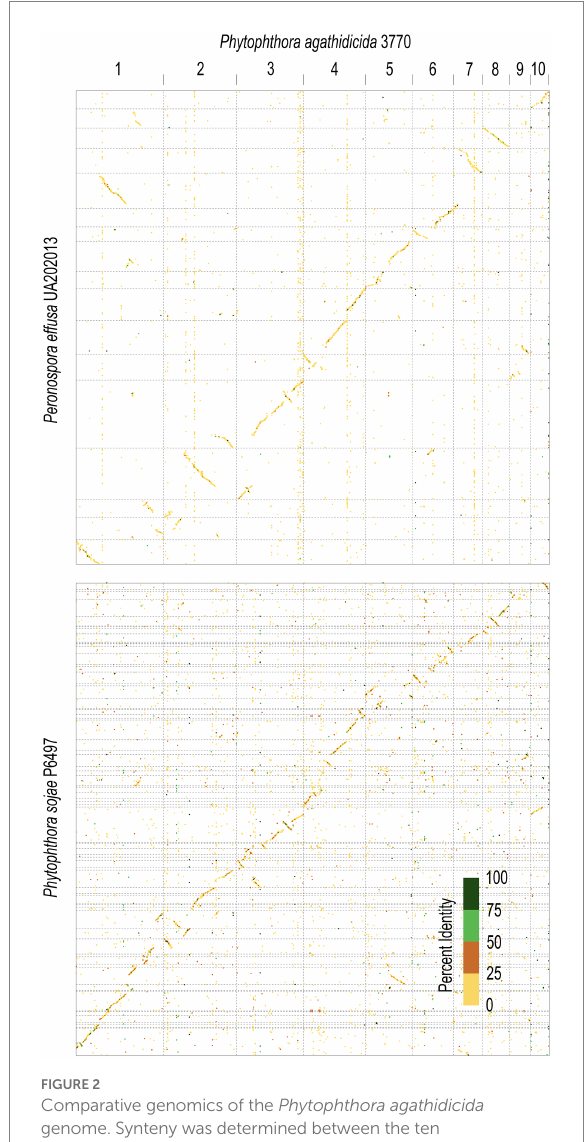
FIGURE 2 Comparative genomics of the Phytophthora agathidicida genome. Synteny was determined between the ten chromosomes of P. agathidicida 3770 and the complete genome of Peronospora effusa UA202013 (top panel) and the fragmentary genome assembly of P. sojae P6497 (bottom panel). Matching colors indicate percent sequence